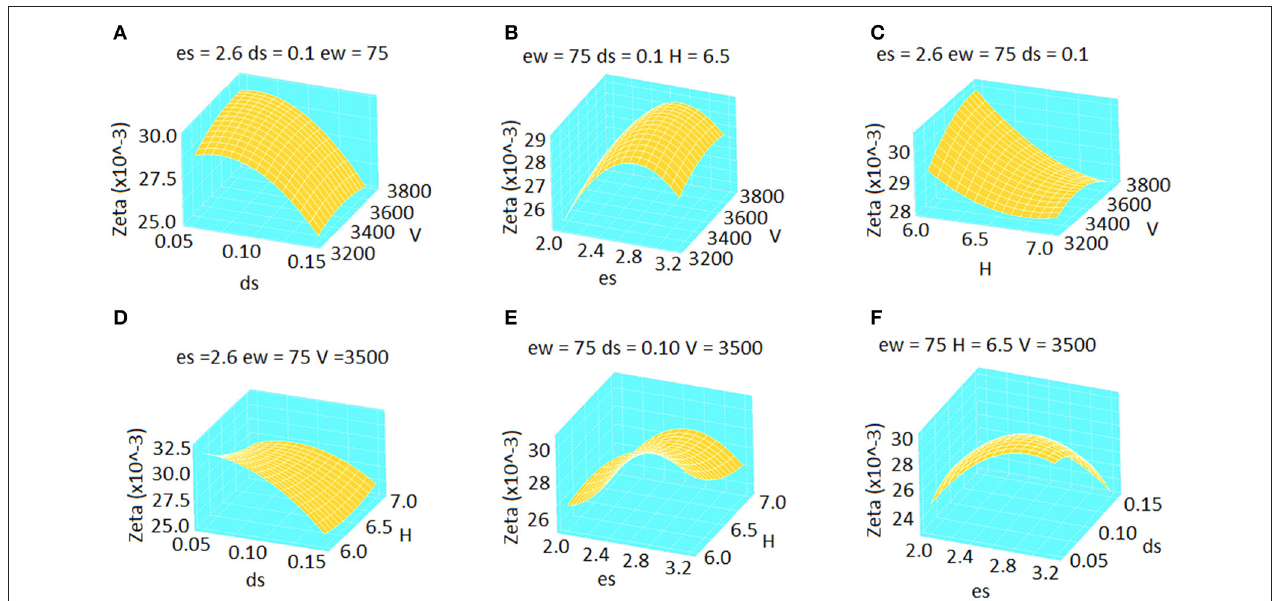
FIGURE 8 | Response surface plots of damping ratio value according to the change in various control factors (A-F) .